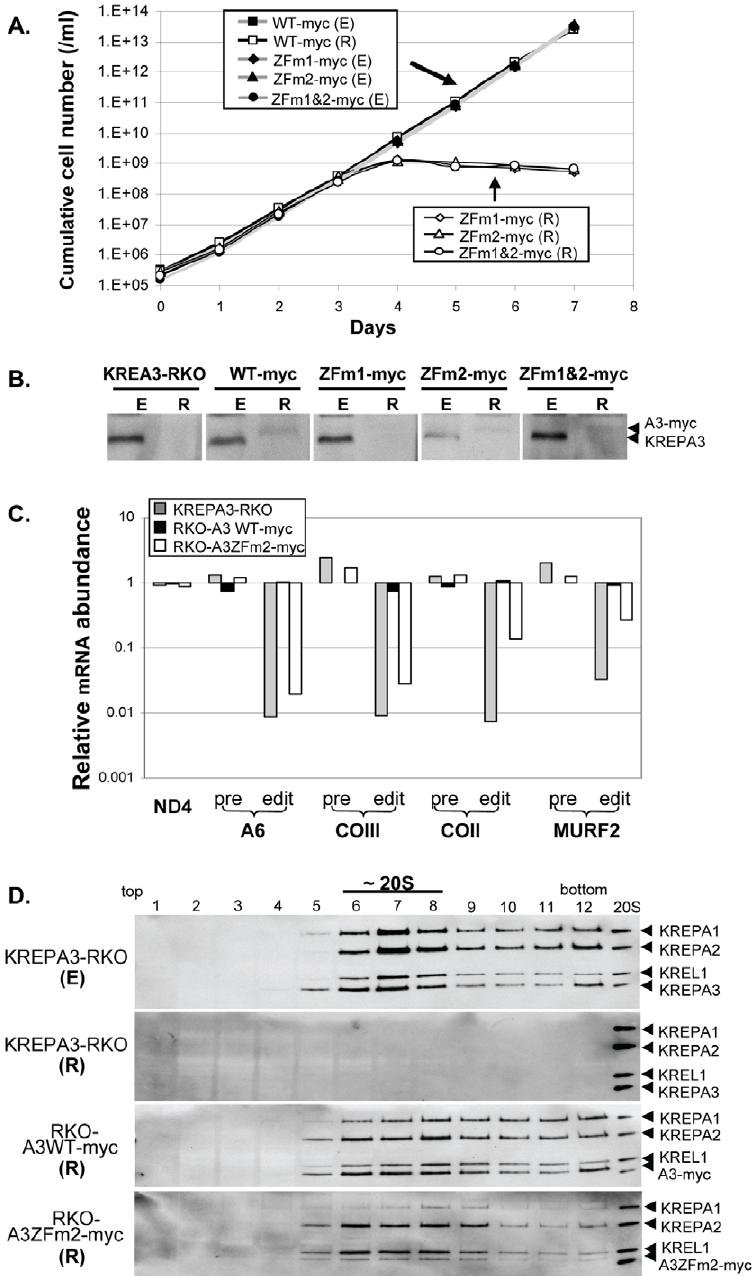
Figure 1. Effects of ZF mutation of KREPA3 with a myc-tag on growth, editing, and editosome integrity. C-terminal myc-tagged WT KREPA3 protein or KREPA3 with mutated ZF1, ZF2, or ZF1&2 were constitutively expressed from the b -tubulin locus and were exclusively expressed upon repression of KREPA3 Reg allele expression by tet withdrawal. ( A ) Growth of RKO-KREPA3 WT-myc, ZFm1-myc, ZFm2-myc, and ZFm1&2-myc cell lines in which KREPA3 Reg was expressed (E) (grey line and solid symbol) or repressed (R) (black line and open symbol). Only WT-myc cells survive after KREPA3 Reg is repressed. ( B ) Western analysis using KREPA3-specific MAb to probe samples from the cells in panel A with KREPA3 Reg expressed (E) or repressed (R) for three days; parental cell line KREPA3-RKO is used as a control. ( C ) Real time PCR analysis of in vivo RNA editing in RKO-A3 WT-myc or ZFm2-myc cells in which KREPA3 Reg was repressed for three days. The relative amounts of pre-edited and edited mRNAs A6, COIII, COII, and MURF2 and never-edited ND4 mRNAs was normalized to 18S rRNA and compared to the corresponding cells in which KREPA3 Reg was expressed. The same analysis was done with KREPA3-RKO cells as a control. Note the log scale and that 1 represents no difference, . 1 an increase, and , 1 a decrease in relative RNA amount. ( D ) Western analysis of the glycerol gradient fractions of crude mitochondrial lysates from RKO- KREPA3 cells in which KREPA3 Reg was expressed (E) or repressed for three days (R) or from RKO-A3 WT-myc or ZFm2-myc cell in which myc tagged WT or ZF2 mutated KREPA3 was exclusively expressed, respectively, by three days repression (R). The analyses used a mixture of MAbs specific for the KREPA1, KREPA2, KREL1, and KREPA3 , 20S editosome proteins. Purified , 20S editosomes used as a control show the size of the untagged KREPA3 protein.